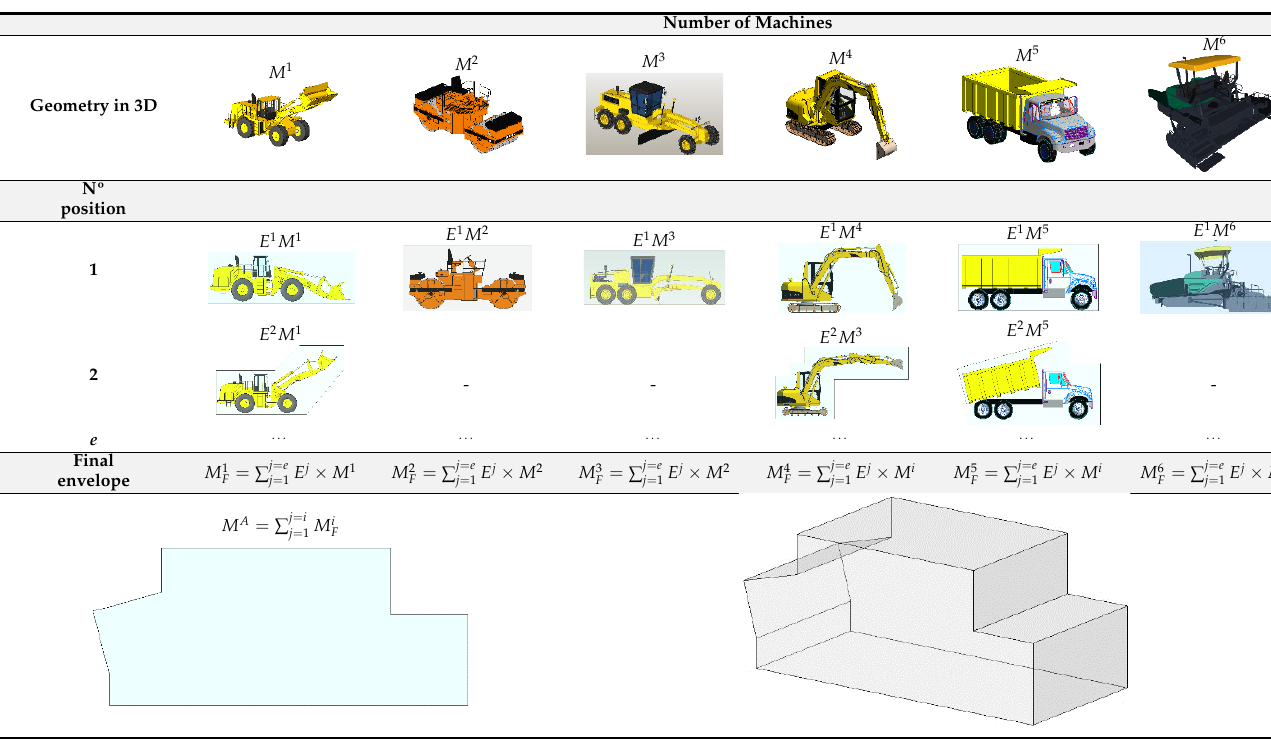
Table 2. Creation of the machinery envelope. Around the image of the machine the perimeter of the envelope of each position is drawn.